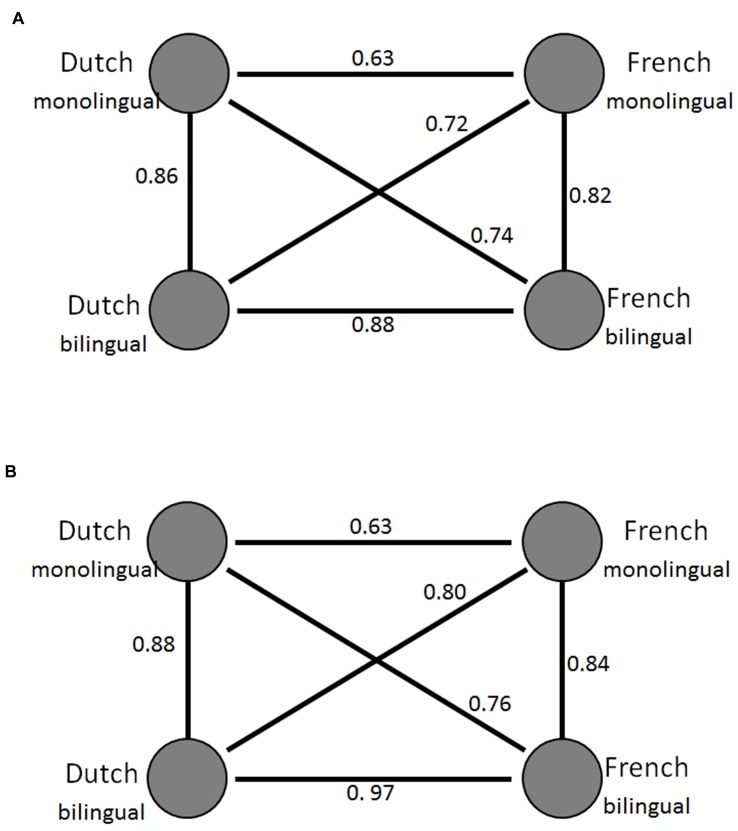
Patterns of correlation between the name distributions of the language groups. Dutchmonolingual denotes the naming patterns of the Dutch-speaking monolinguals, Frenchmonolingual the naming patterns of the French-speaking monolinguals, Dutchbibilngual and Frenchbilingual the naming patterns of the bilinguals in Dutch and French, respectively. (A) The correlations reported in Figure 5D in Ameel et al. (2005). (B) The correlations from our standard model. The circles represent the naming patterns. The lines between the circles express the relations between the naming patterns. The numbers next to the lines show the correlation coefficient between the naming patterns.